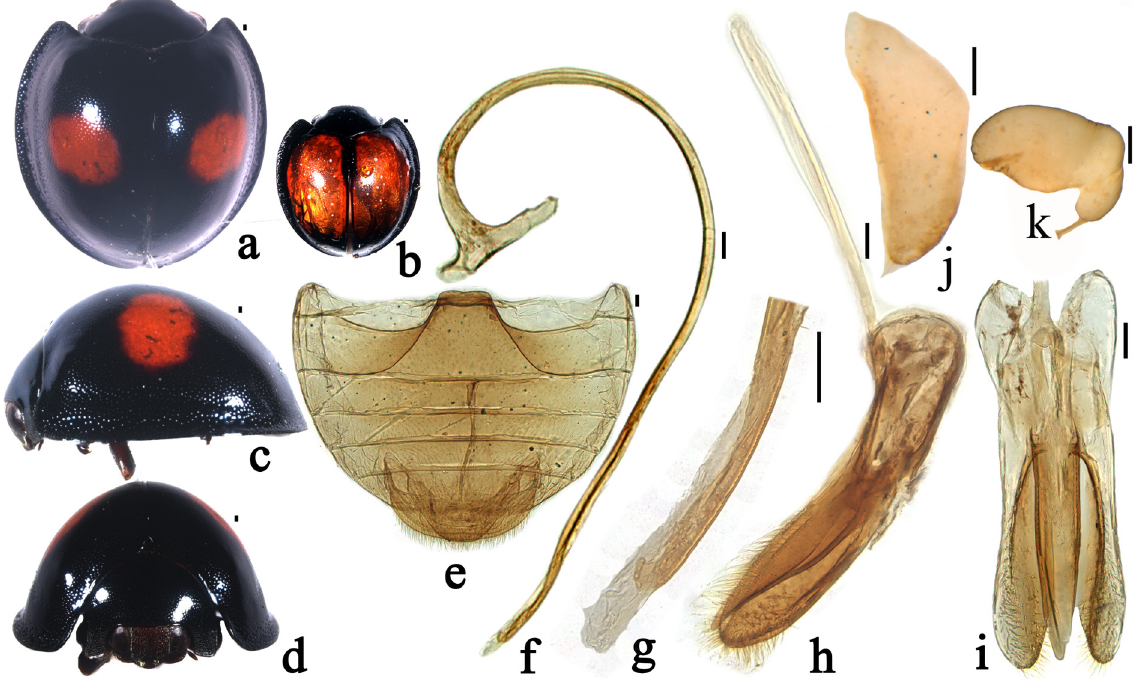
Fig. 11. Chilocorus chalybeatus Gorham, 1892. a–b . Dorsal view. c . Lateral view. d . Frontal view. e . Abdomen. f . Penis. g . Apex of penis. h . Tegmen, lateral view. i . Tegmen, ventral view. j–k .